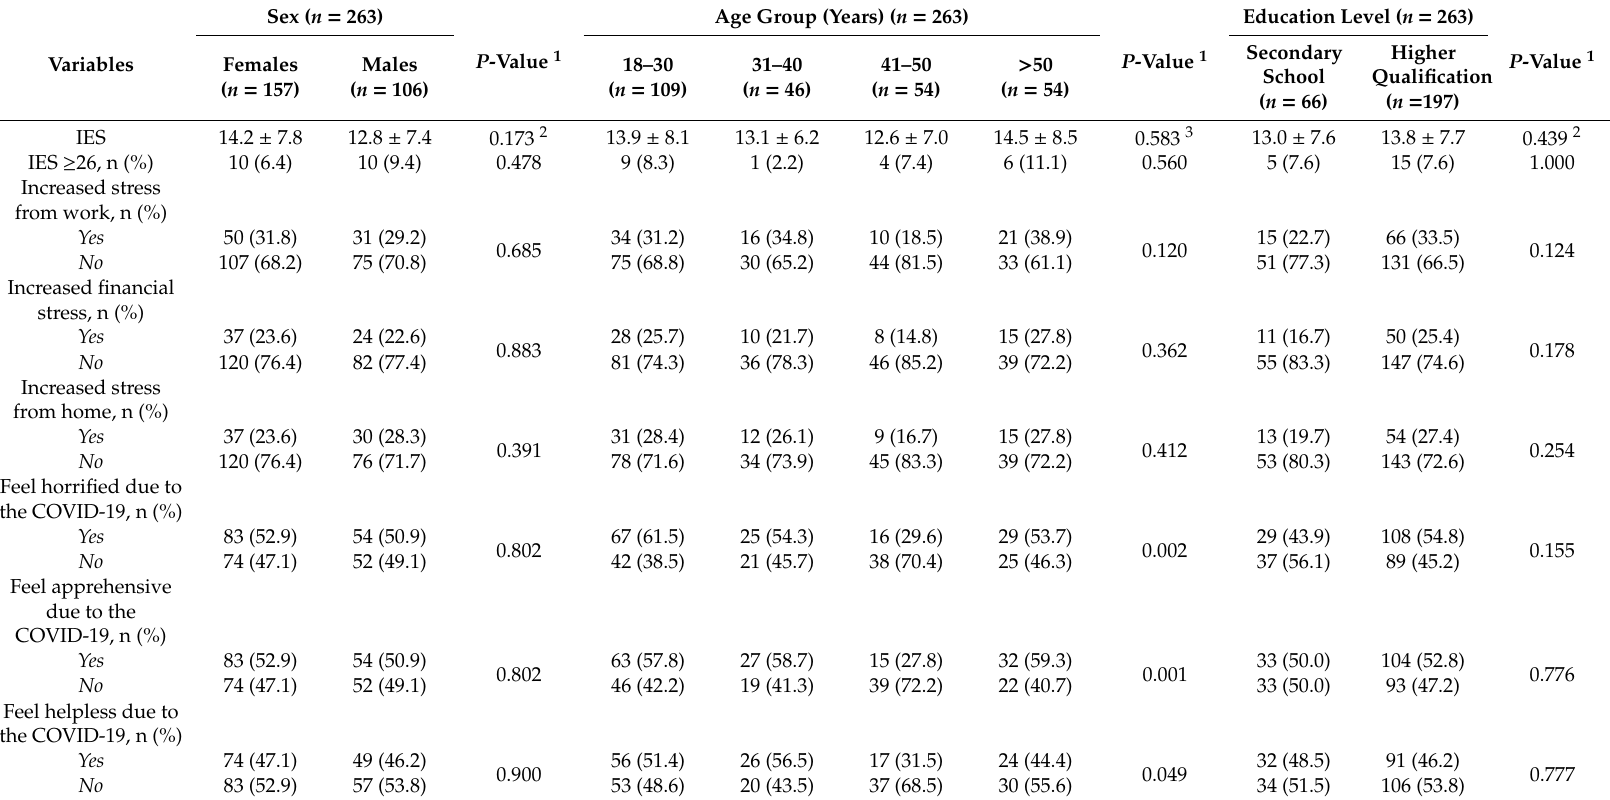
Table 3. IES and negative health impacts by demographic